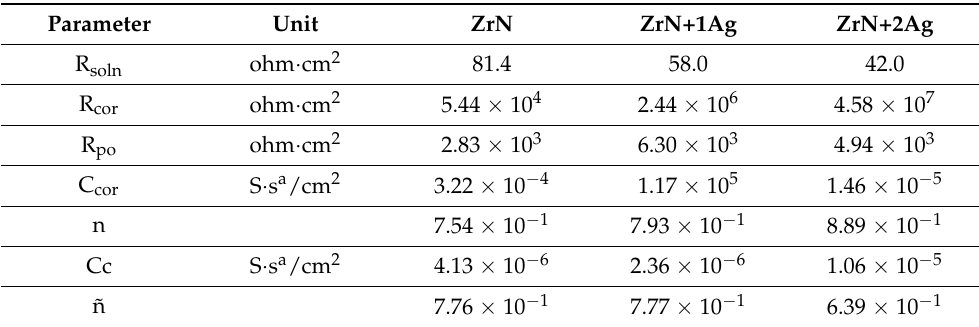
Table 7. EIS fitting parameter of ZrN, ZrN+1Ag, and ZrN+2Ag coatings after 216 h of immersion in a Ringer’s solution at 37.5 ◦